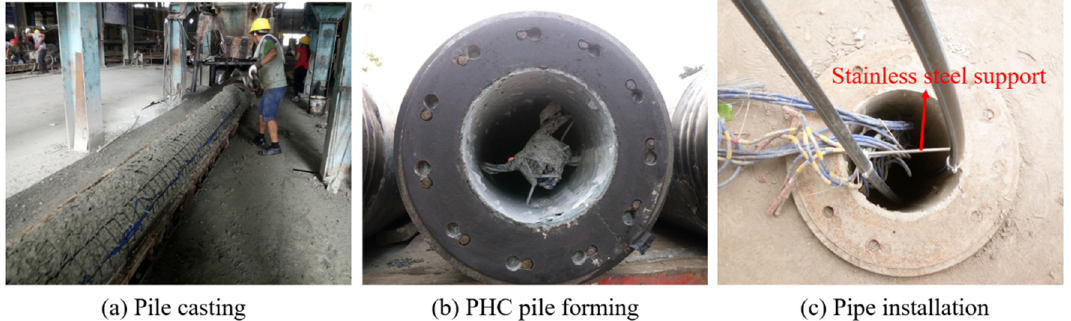
Figure 2. Manufacture and installation of PHC energy pile in the